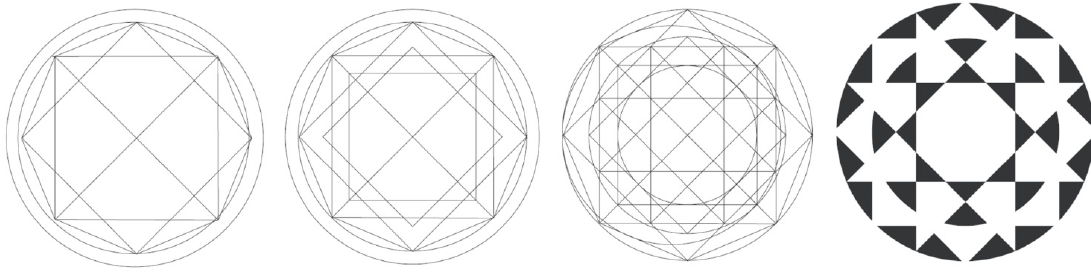
Figure 14. Common Fate.